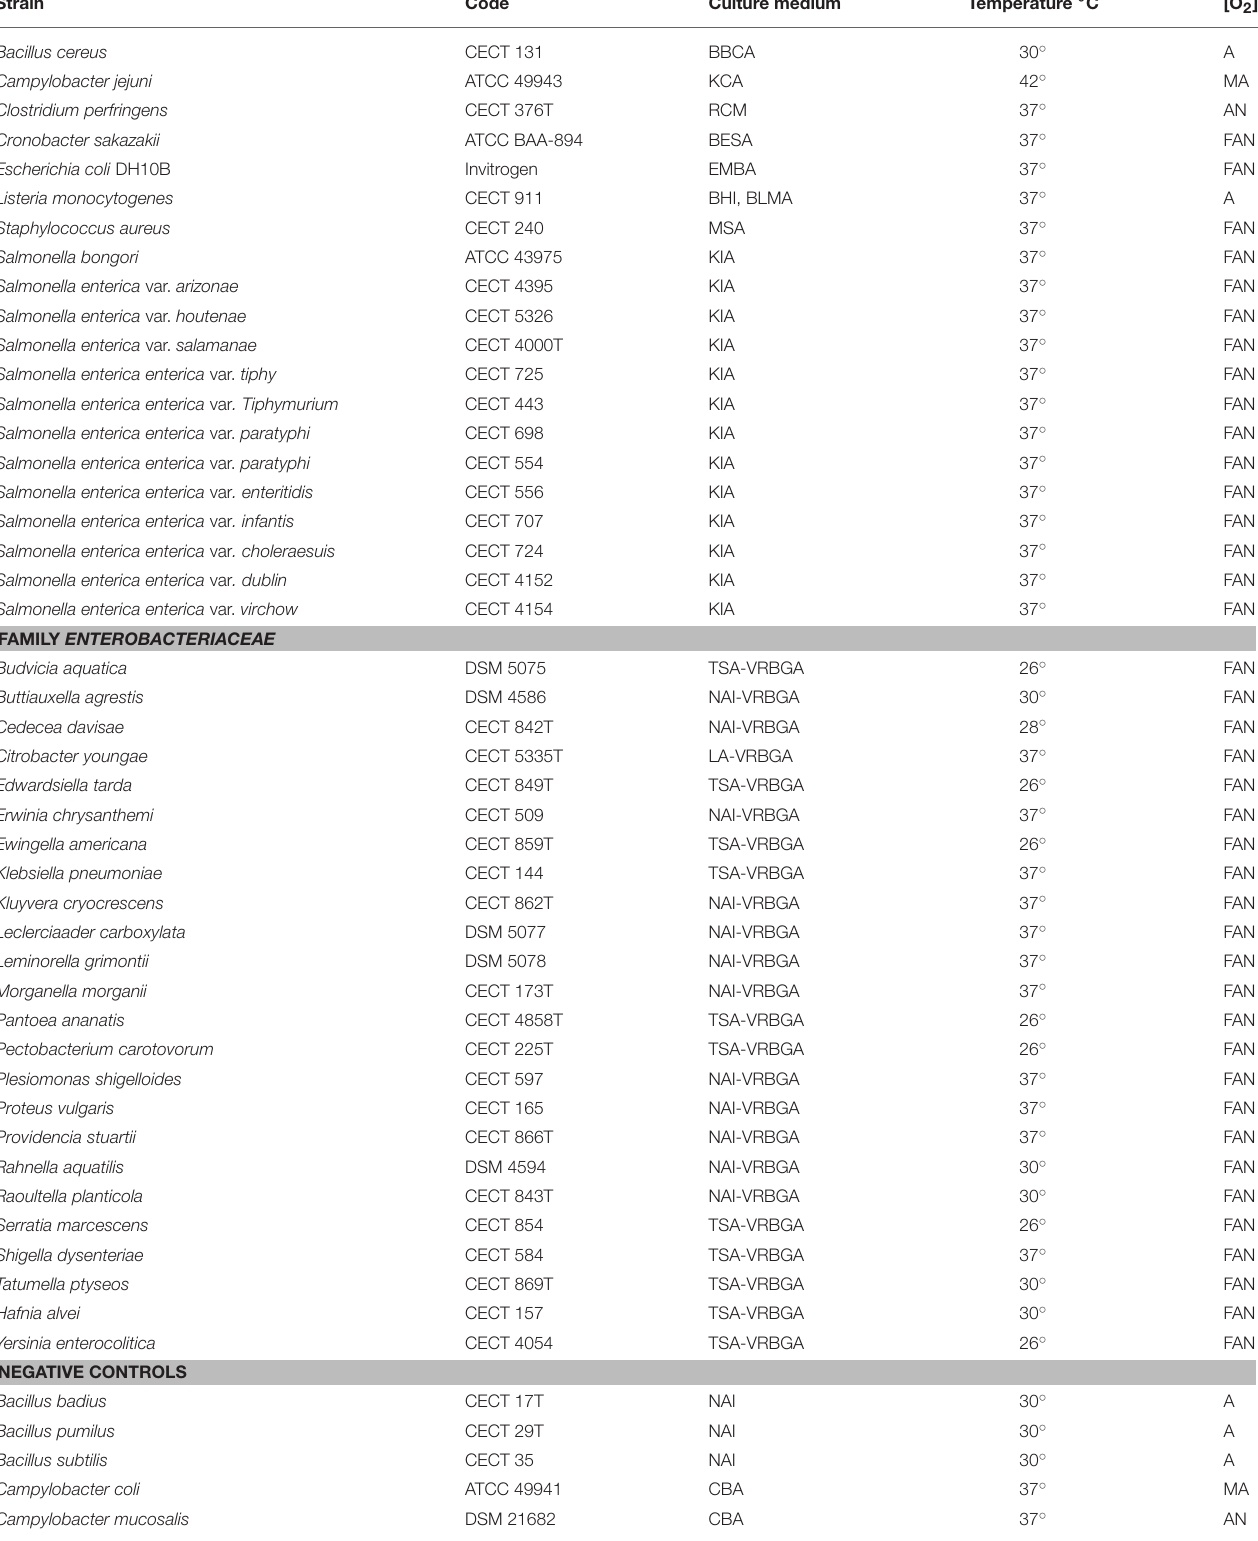
TABLE 1 | List of target species in this work, including Enterobacteriaceae and negative control species.